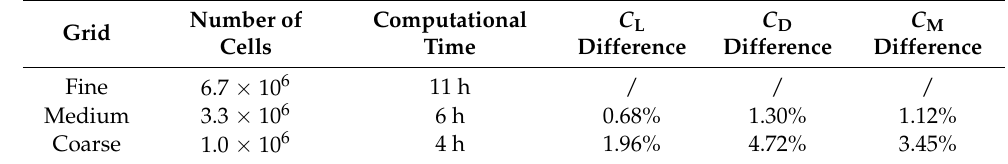
Table 4. Results of grid independence test for the present BWB configuration. Table 4 . Results of grid independence test for the present BWB configuration.